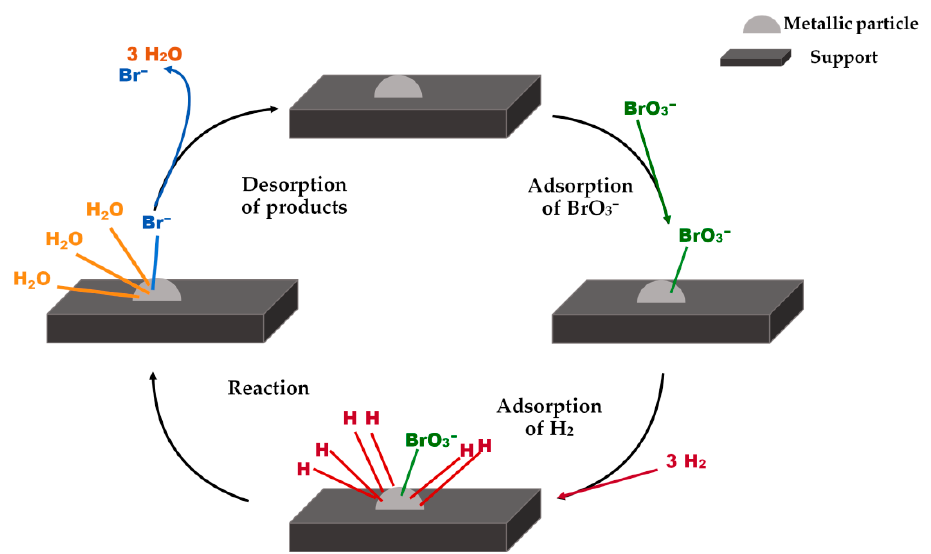
Figure 7. Langmuir–Hinshelwood mechanism for the bromate catalytic hydrogenation over supported metallic particles .